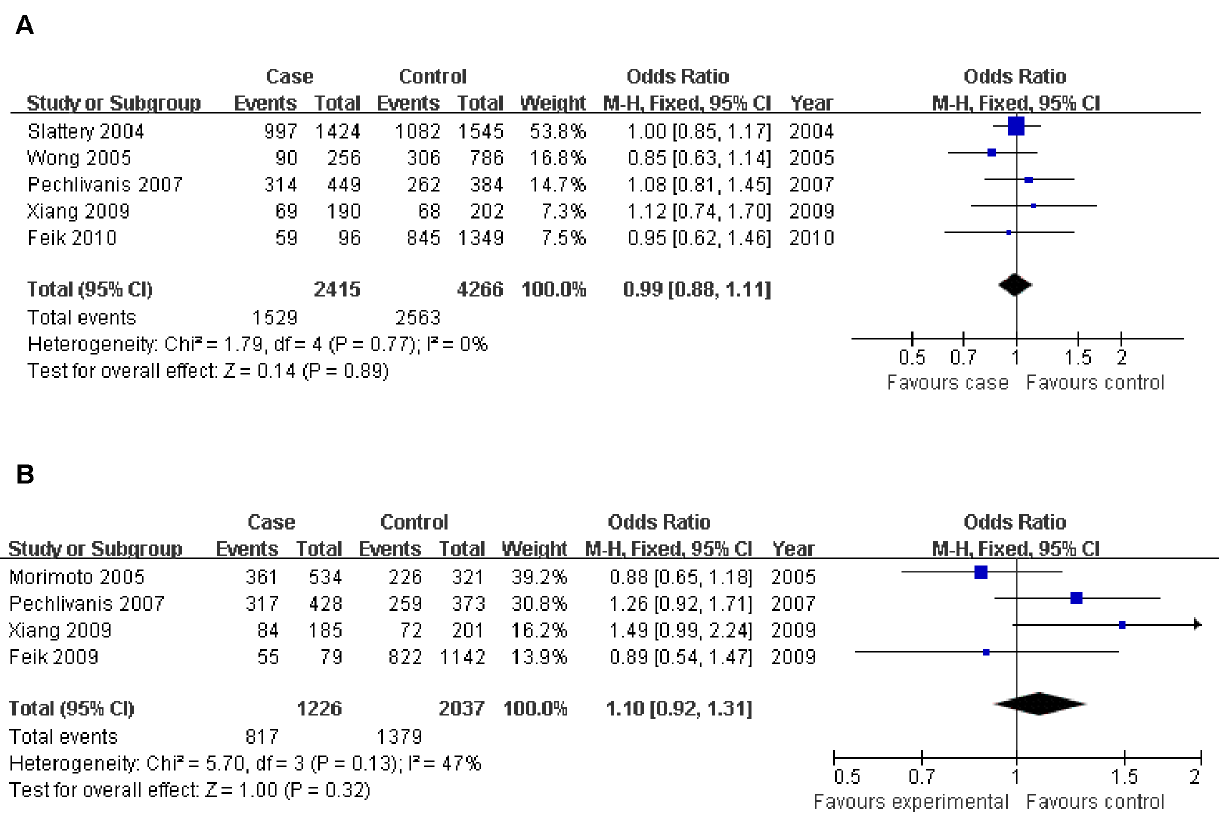
Figure 2. Association of IGFBP3 A-202C and Gly32Ala polymorphisms with colorectal cancer risk. Each comparison was presented by the year of publication. Part A analyzed the comparison between IGFBP3 A-202C(AC vs. AA) and colorectal cancer, par B analyzed the comparison between Gly32Ala polymorphism (GC vs. GG) and colorectal cancer.